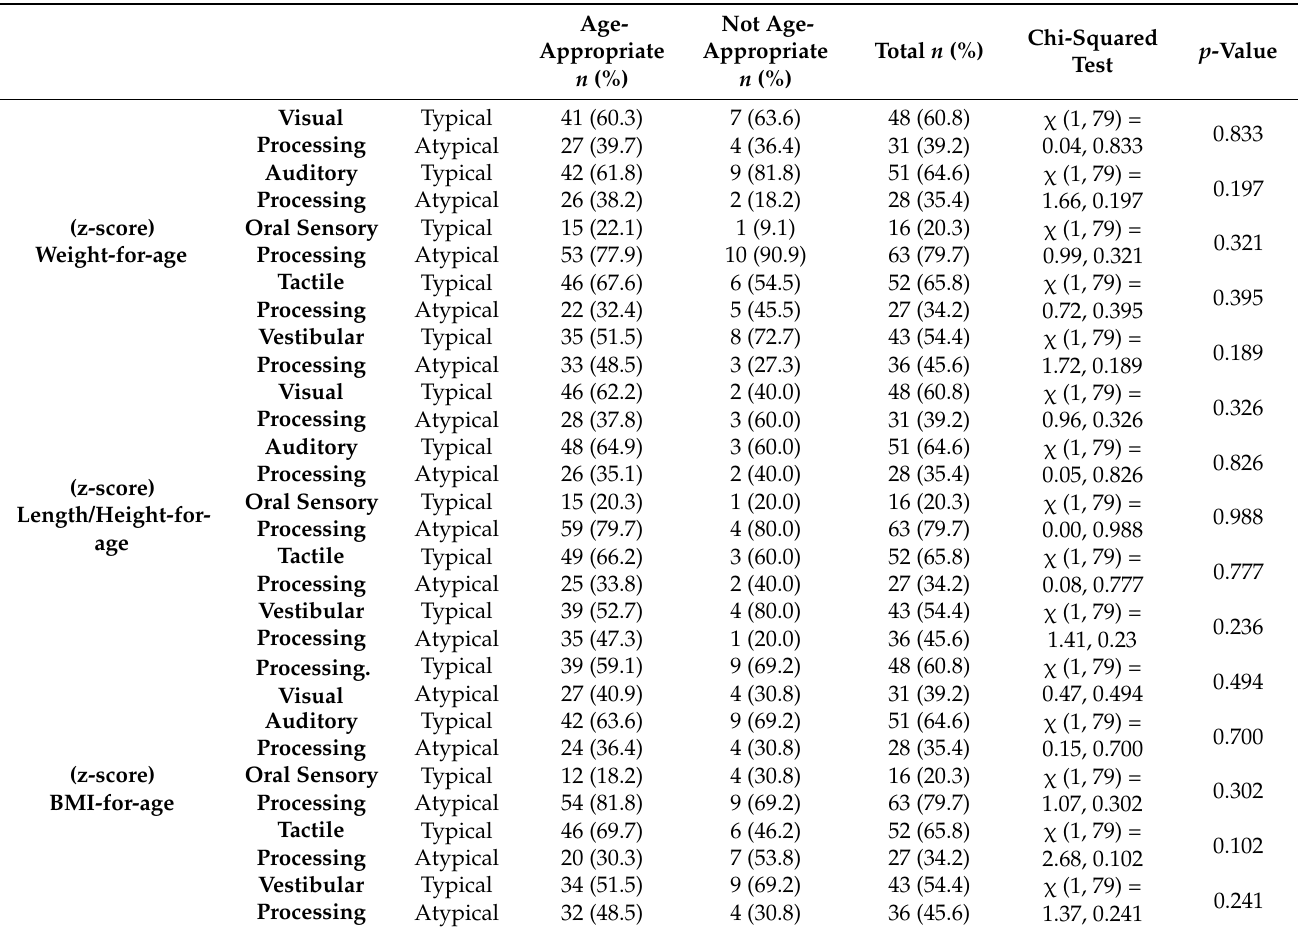
Table 5. Relationship between weight-for-age (z-score), length/height-for-age (z-score), and BMI-for-age (z-score) (all dichotomous) anthropometric indices and sensory processing (all